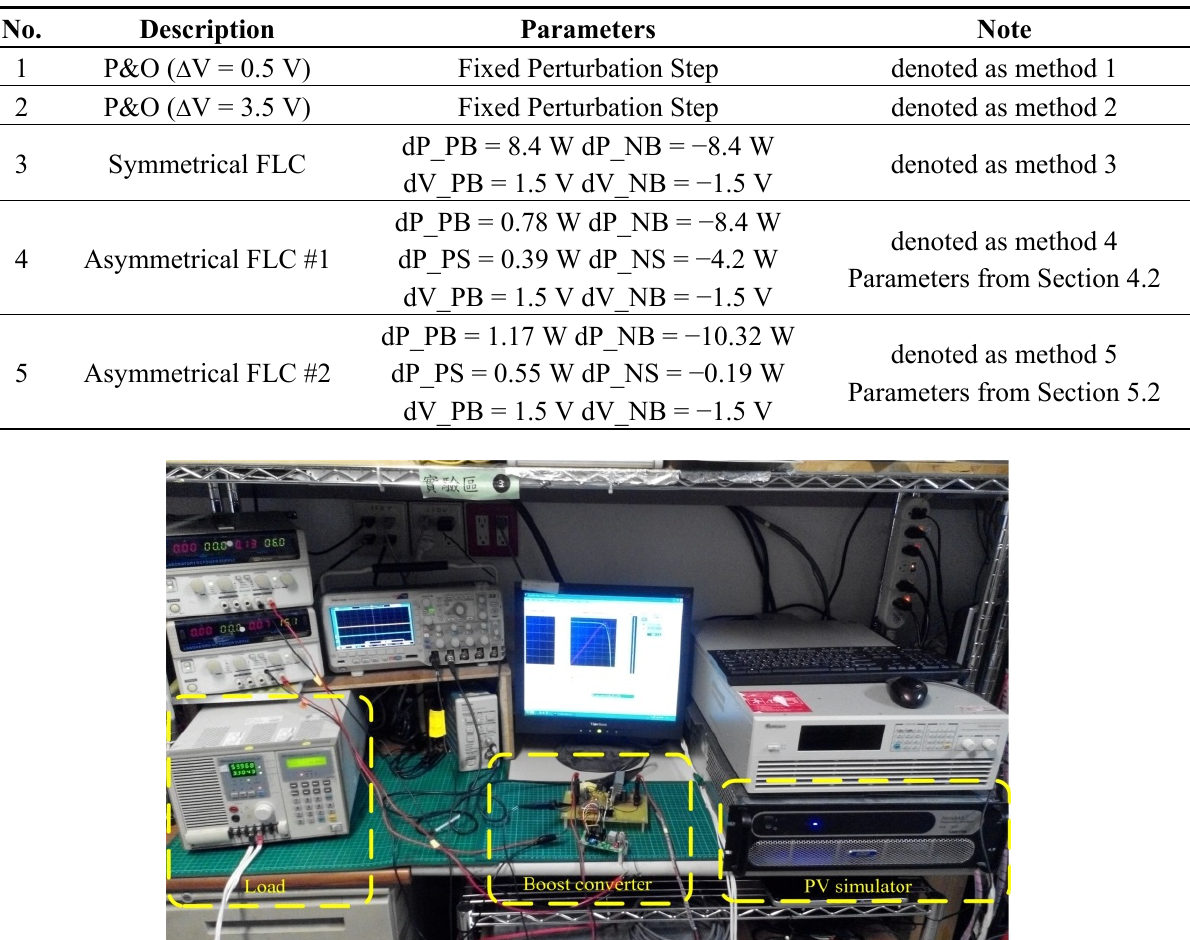
Table 4. Parameters of the implemented algorithms.